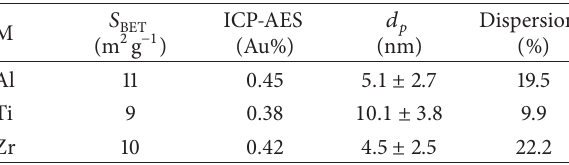
Table 1: 𝑆 , Au content, and average Au-NPs size by TEM BET characterization of Au/P[VBTACl]-M